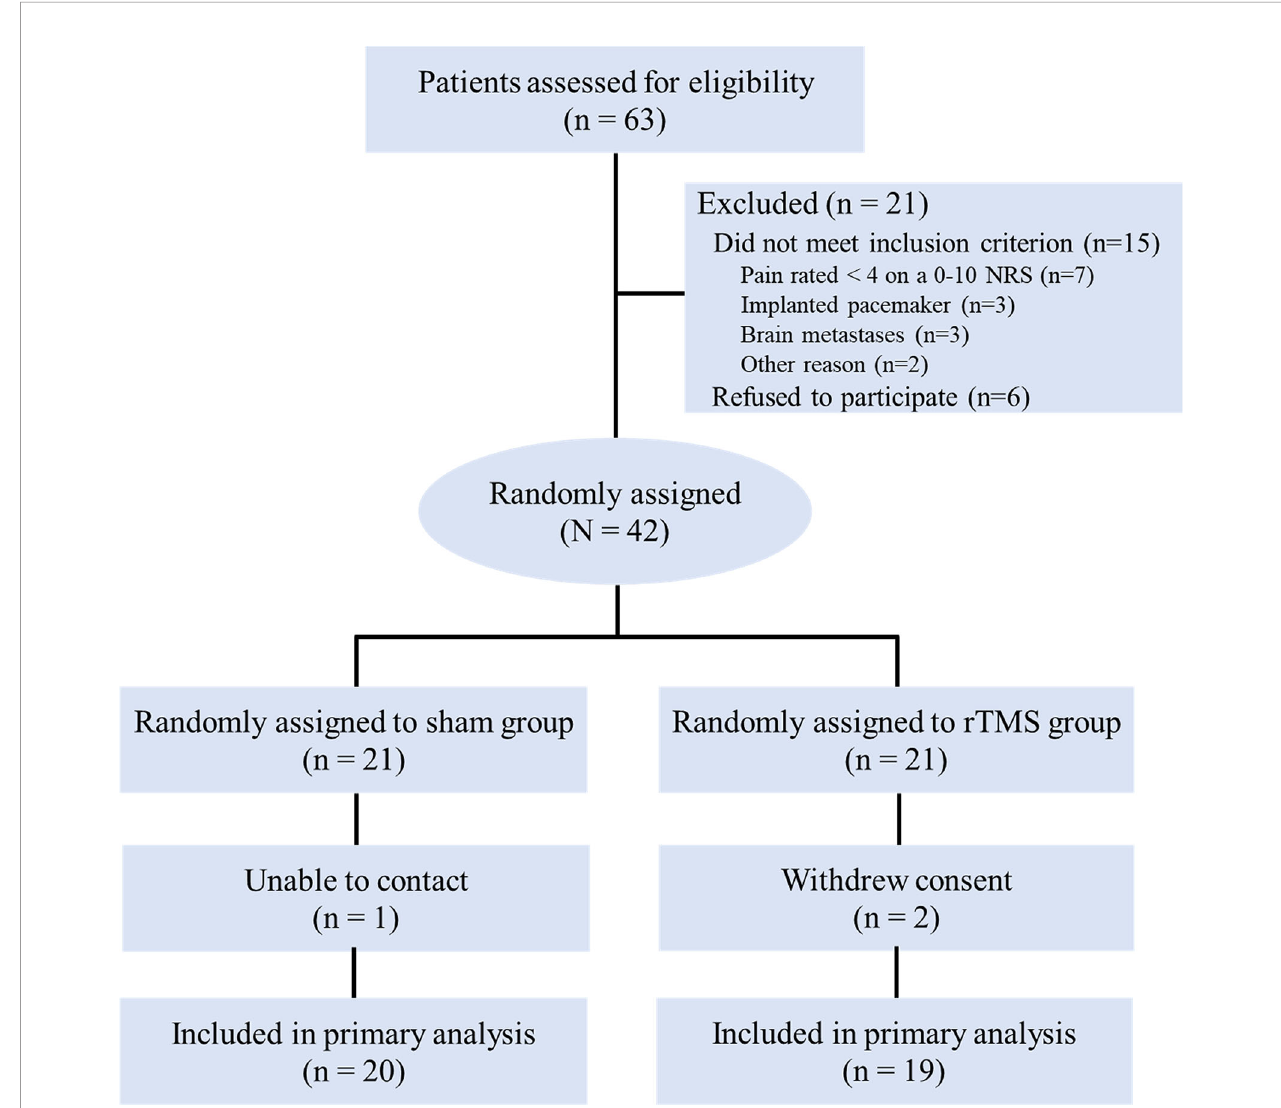
FIGURE 2 | CONSORT diagram. NRS, numeric rating scale; rTMS, repetitive transcranial magnetic